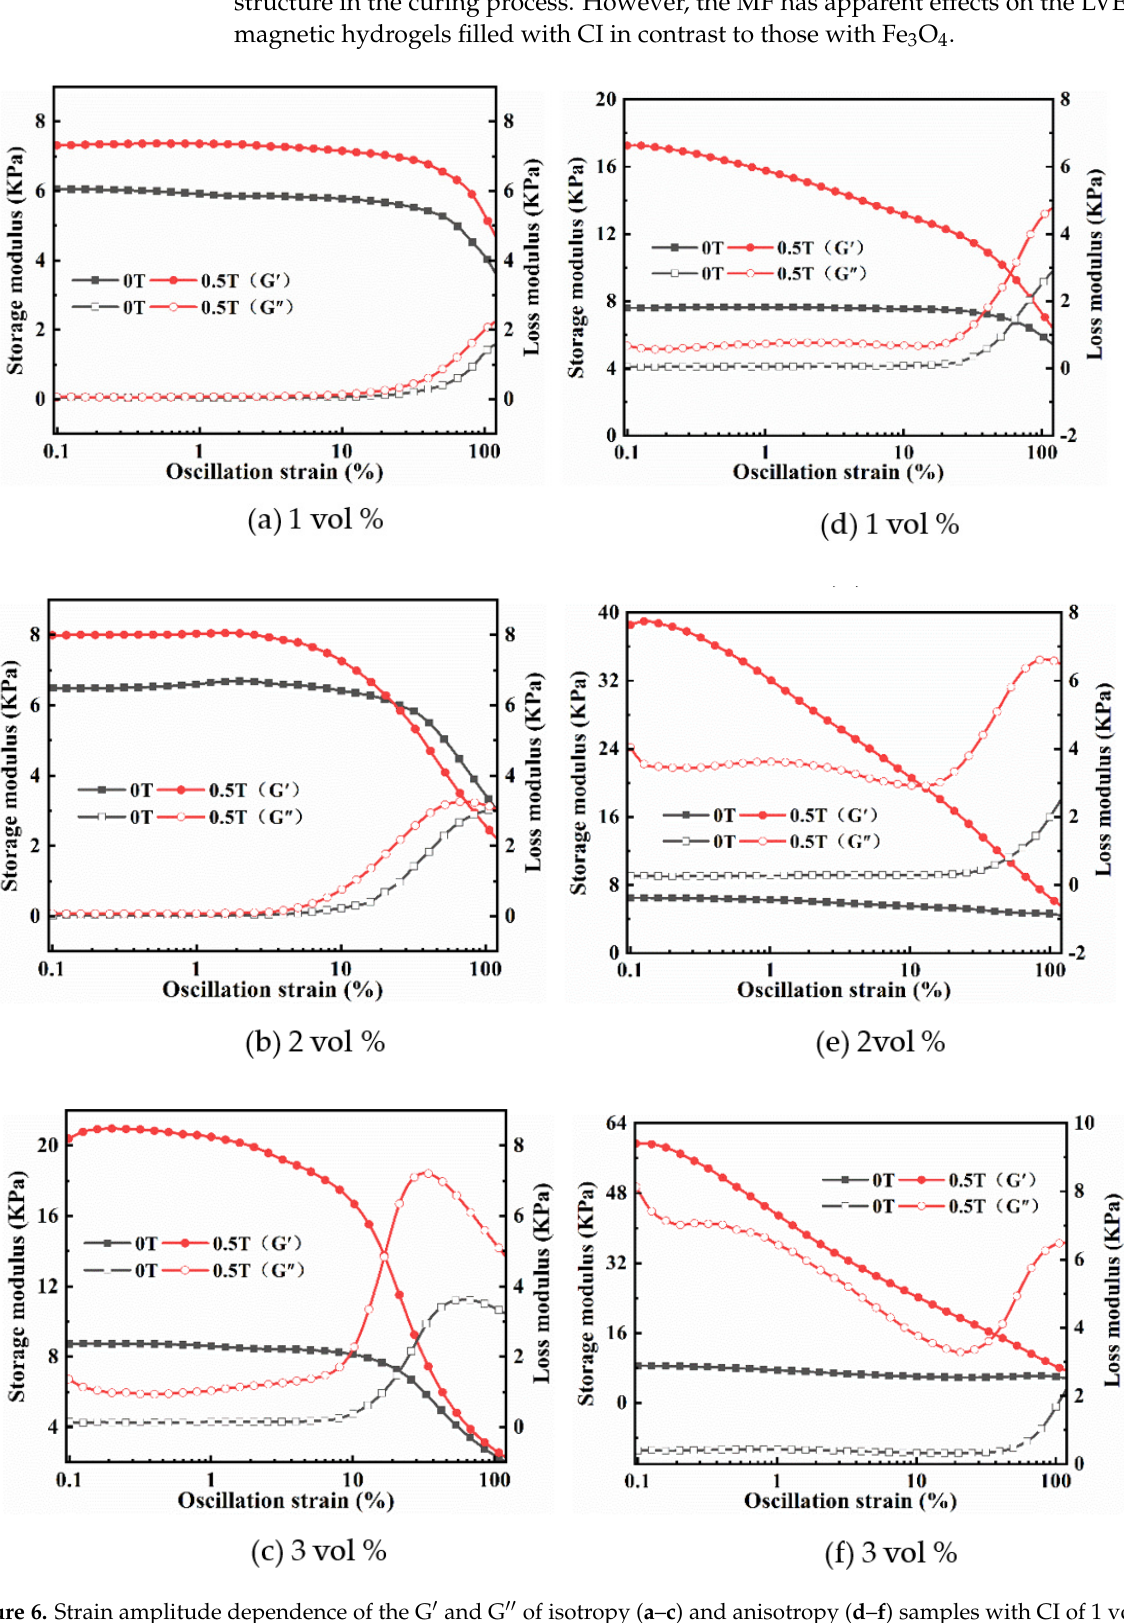
Figure 6. Strain amplitude dependence of the G’ and G” of isotropy ( a – c ) and anisotropy ( d – f ) samples with CI of 1 vol%, 2 vol% and 3 vol% under 0 T and 0.5 T at a fixed frequency of 10 rad/s.